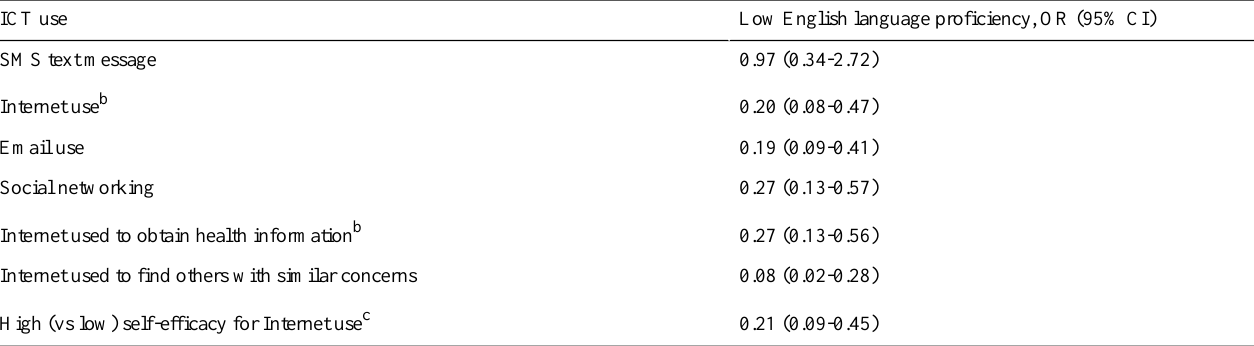
Table 3. Odds of information and communication technology (ICT) use for women with low vs adequate English proficiency.